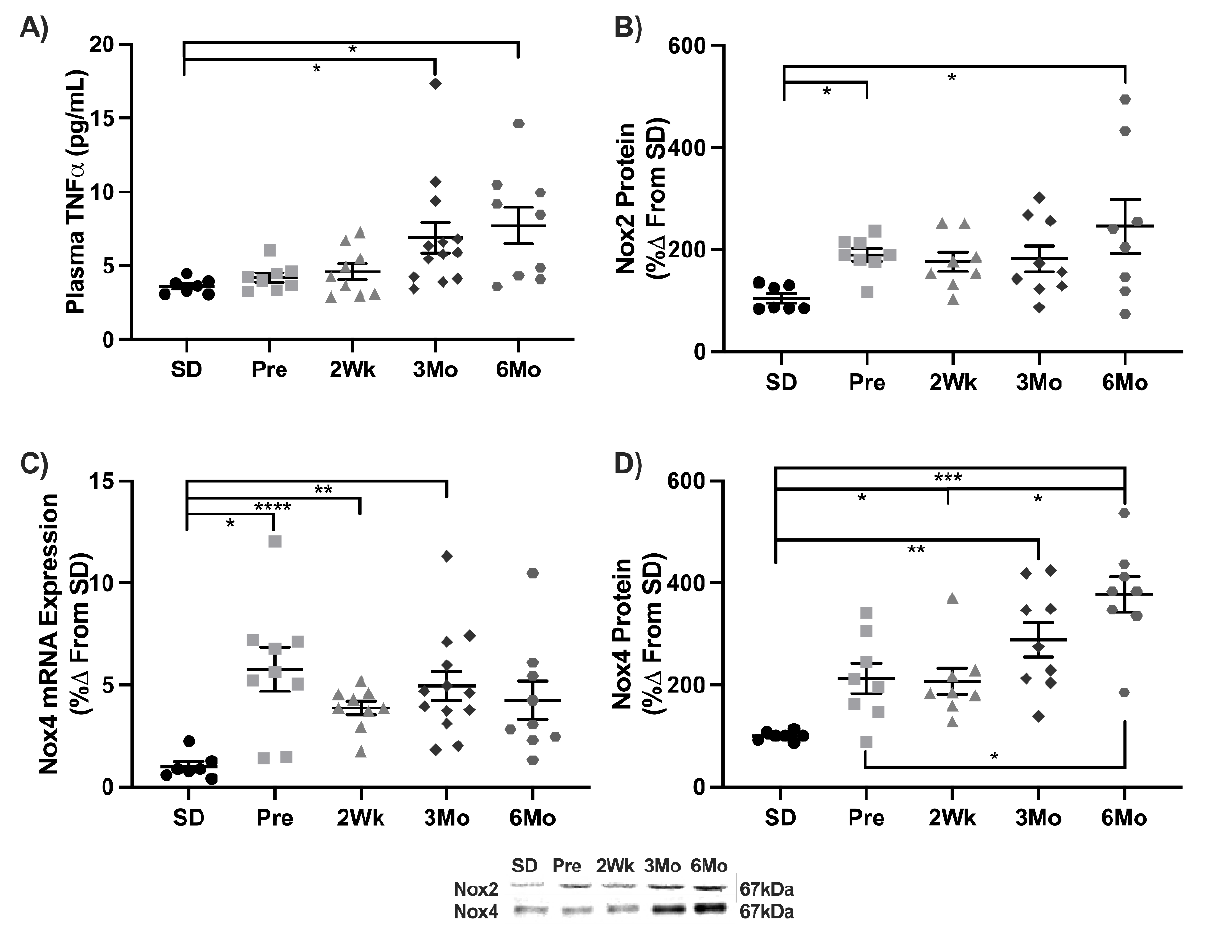
Figure 2. Downstream targets of NF- κ B activation. Mean ± SEM values of ( A ) plasma TNF α , ( B ) Nox2 protein, ( C ) Nox4 mRNA, and ( D ) Nox4 protein in Sprague-Dawley (SD; n = 7), pre-diabetic UCD-T2DM (Pre; n = 9), 2-week diabetic UCD (2Wk; n = 9), 3-month diabetic UCD-T2DM (3Mo; n = 13), and 6-month diabetic UCD-T2DM (6Mo; n = 9) rats. * p < 0.05, ** p < 0.01, *** p < 0.001, **** p < 0.0001.